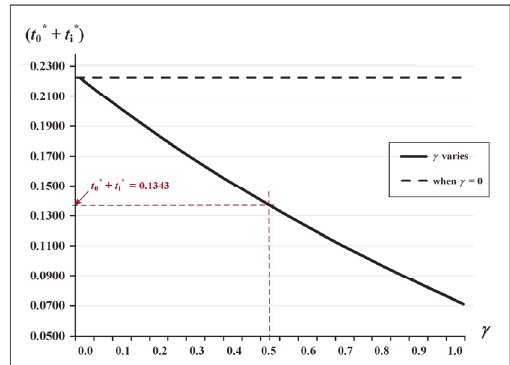
Fig. 14. The effect of linear and nonlinear relationships between  and  on E [ TCU ( T *)]